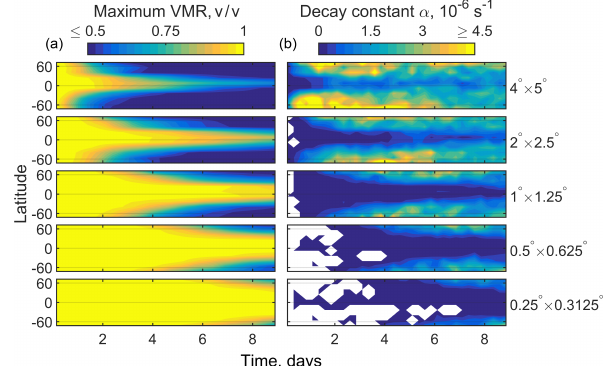
Figure 4. Dependence of plume decay on the stretching of the at- mospheric flow as measured by the Lyapunov exponent. The figure shows the average plume decay constant α over 9 days of aging and the normalized plume size after 9 days, in a 90-member ensem- ble of 2-D plume simulations worldwide (Fig. 1). Each datapoint corresponds to a single plume and the grid resolution is identified by color. Linear regression lines are calculated using reduced ma- jor axis regression, discounting points below the “regression cutoff” line. The slopes are shown next to the regression lines. Values of r 2 are in the range 0.49 to 0.62 for all